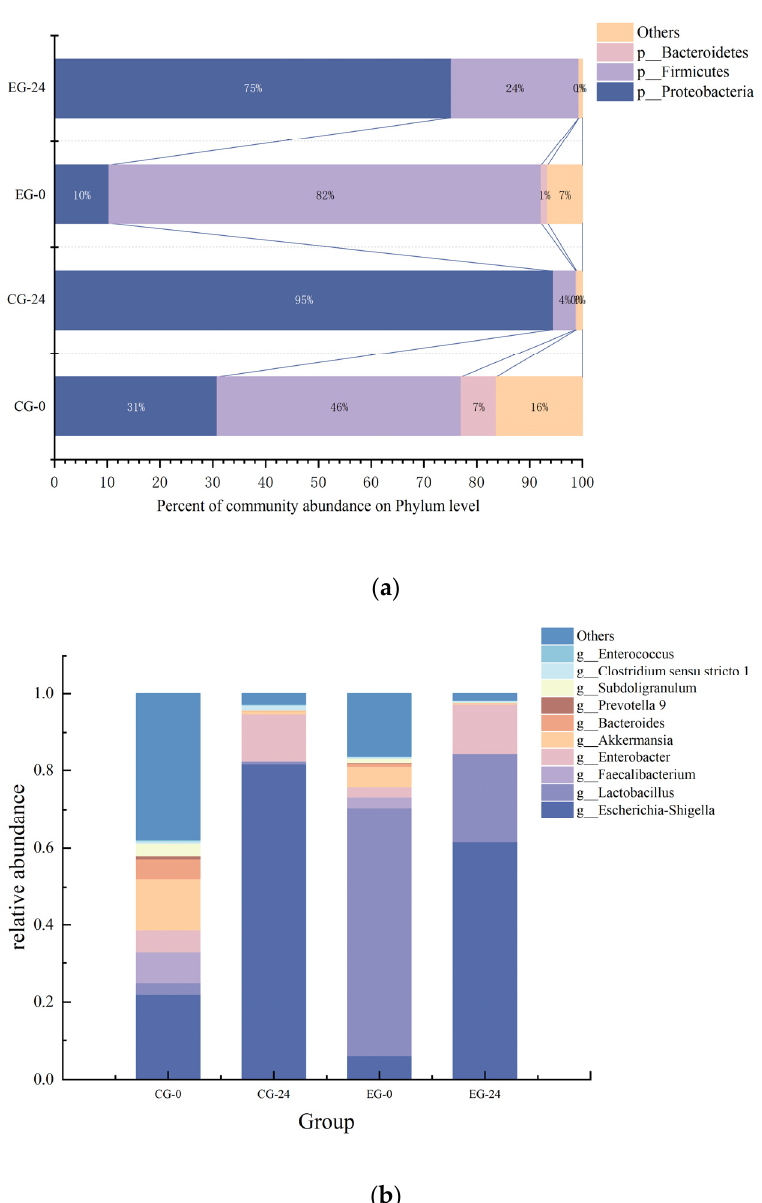
Figure 6. ( a ): Phylum-level species distribution; ( b ): Genus-level species distribution. In summary, M3 (1) has a significant inhibitory effect on the harmful microorganism E. coli/Shigella in the intestine without affecting the indigenous microorganisms such as Enterobacter , and to some extent, it promotes the growth of Lactobacillus . It has a positive regulatory effect on the intestinal flora of IBD